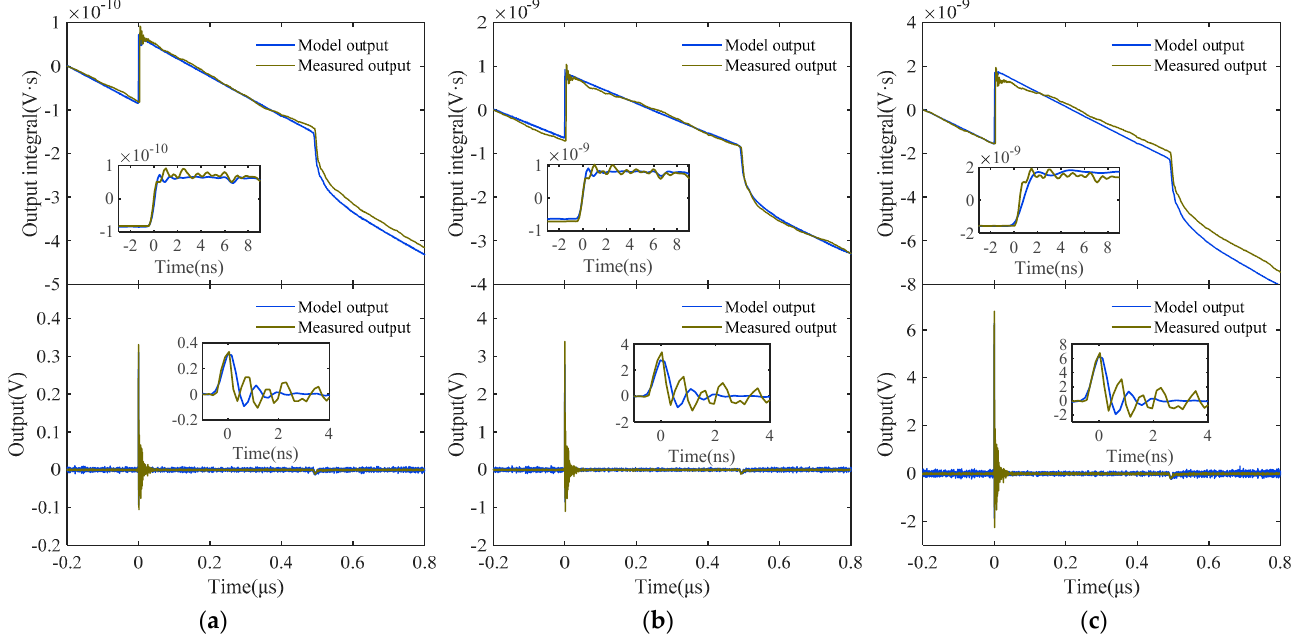
Figure 9. Comparison of the model output with the actual output of the measuring system under different square pulse excitation voltages: ( a ) 50 V; ( b ) 500 V; ( c ) 1500 V.